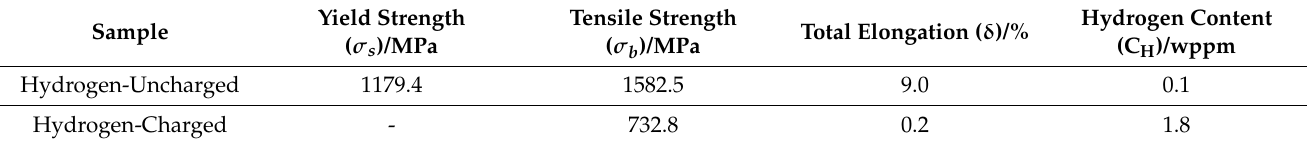
Figure 2. Stress-strain curves of 22MnB5 steel obtained by SSRT, tested at room temperature with and without hydrogen charging. Table 2. Mechanical properties of 22MnB5 steel specimens with and without hydrogen charging.